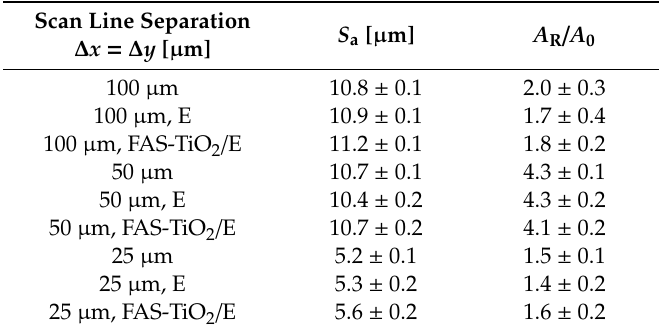
Table 1. Average surface roughness parameter S a and the ratio between the rough and the smooth surface area, A R / A 0 of uncoated and coated laser-textured